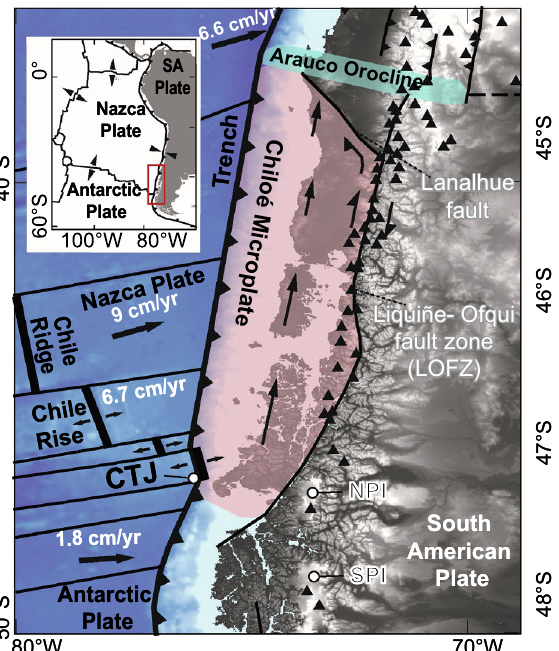
Figure 1. ( A ) Neotectonic and study site setting in Southern Chile and Chilean Patagonian. Master (main trace) of the LOFZ is shown. CTJ is the Chile Triple Junction or Chile Ridge/Rise between the Nazca-Antarctic- South American Plates. NPI is the Northern Patagonian Icecap (or San Valentine Icecap), SPI is the Southern Patagonian Icecap. Late Quaternary volcanoes are shown with black triangles. Oblique subduction here is the driving force for dextral motion (i.e. northwards migration of the Chiloe Microplate, after Forsythe and Nelson 10 and Melnick et al. 21 ) along the LOFZ. Base hillshade was generated with Esri ArcMap v.10.3 software (under fair terms of use, https:// www. esri. com/ en- us/ legal/ copyr ight- trade marks) 39 using a digital elevation model downloaded from ALOS PALSAR Global Radar Imagery 40 with 12.5 m resolution (https:// asf. alaska. edu/ data- sets/ sar- data- sets/ alos-